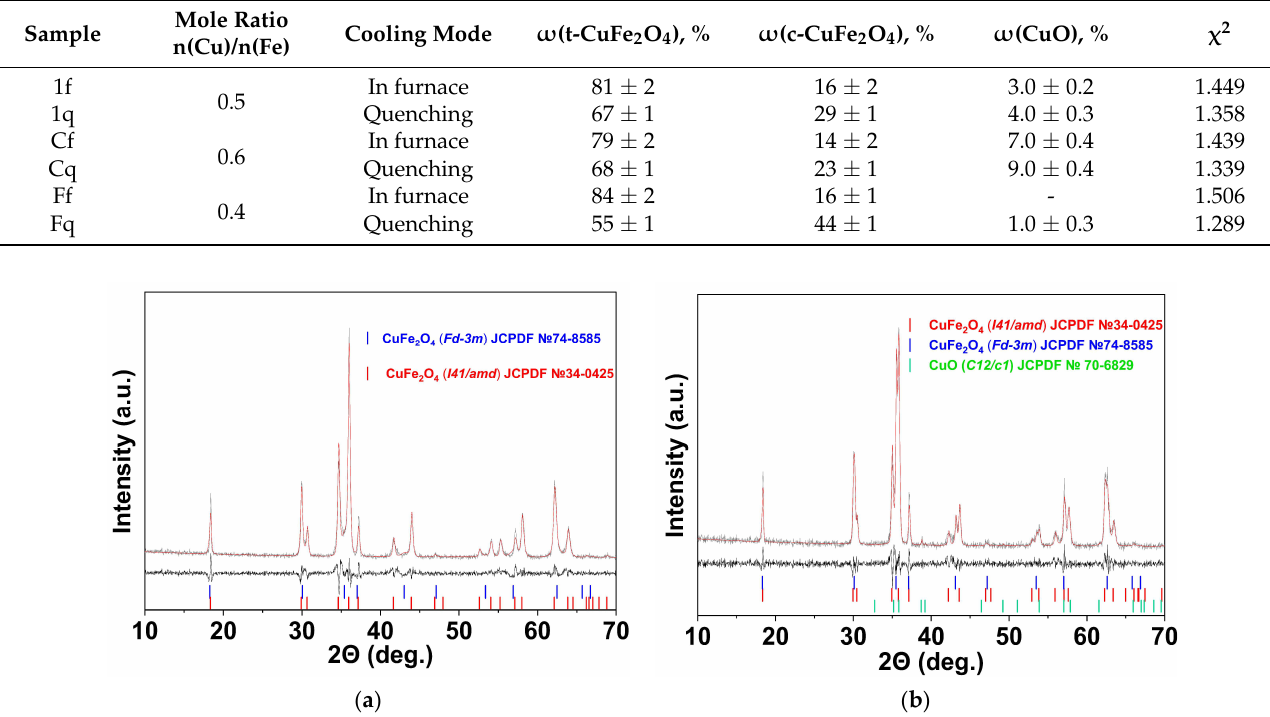
Figure 8. Phase composition of samples Ff ( a ) and Fq ( b ). The red line indicates the calculated model. The difference between both values and the line diagram of phases (c-CuFe 2 O 4 , t-CuFe 2 O 4 , CuO) are presented in the lower portion of the graph are indicated by the black line .